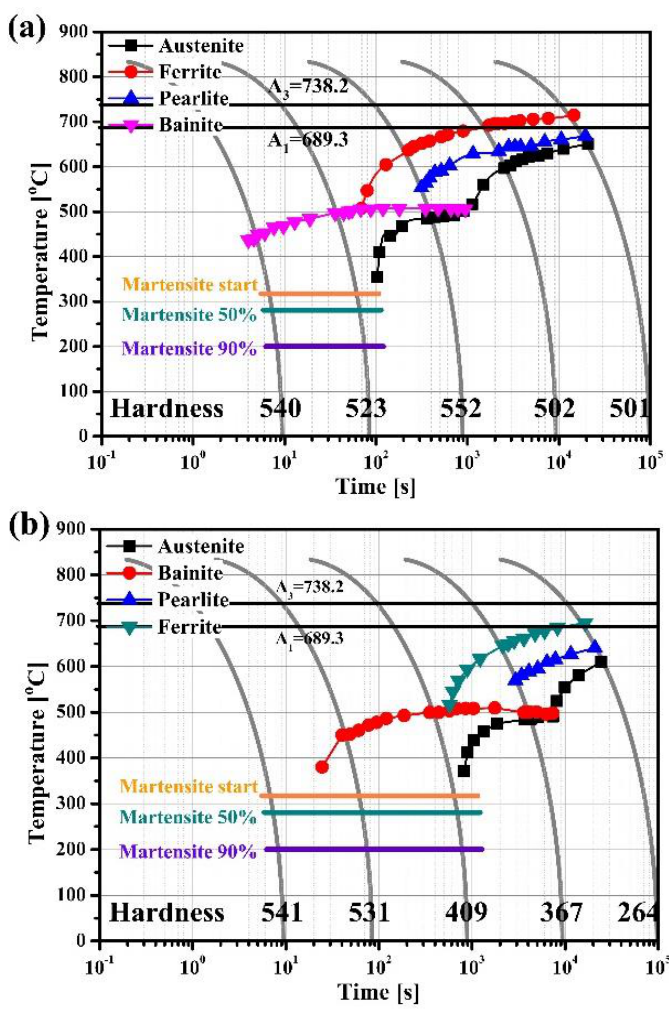
Figure 8. Simulated continuous cooling transformation (CCT) results using JMatPro program for: ( a ) alloy A and ( b ) alloy B.